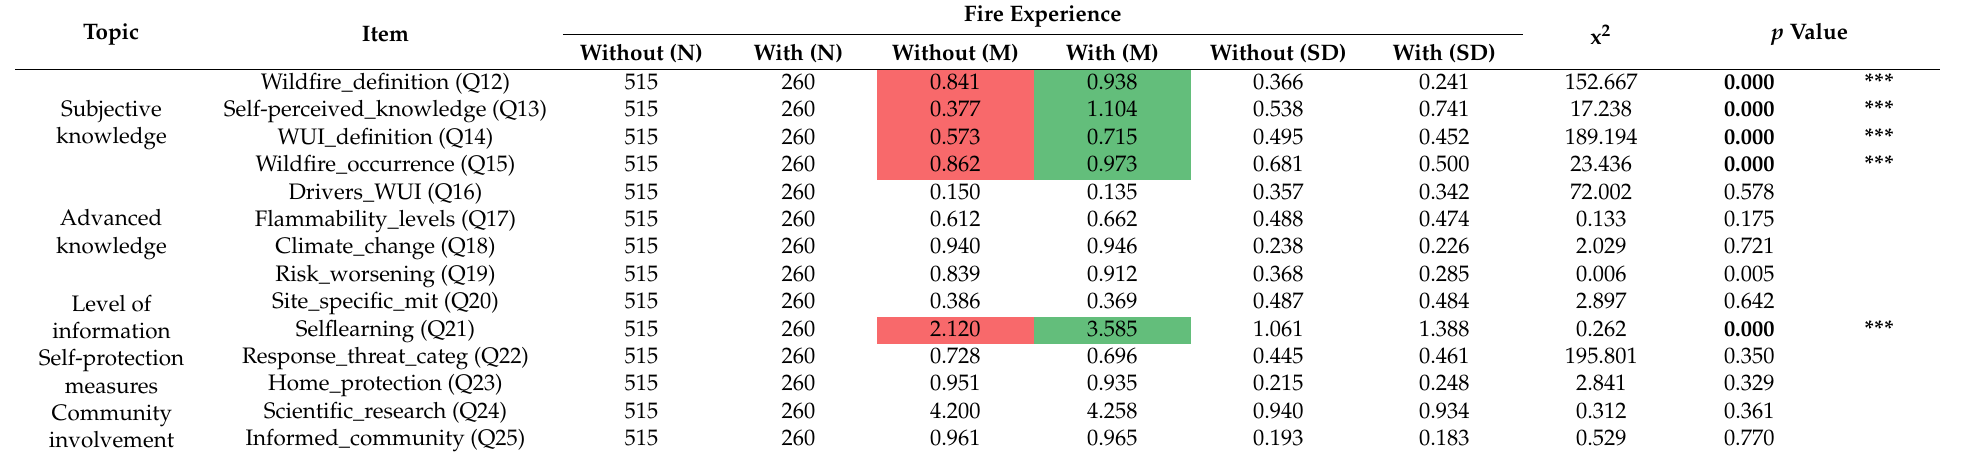
Table 2. Kruskal-Wallis test for differences in the responses between participants with and without direct wildfire experience.